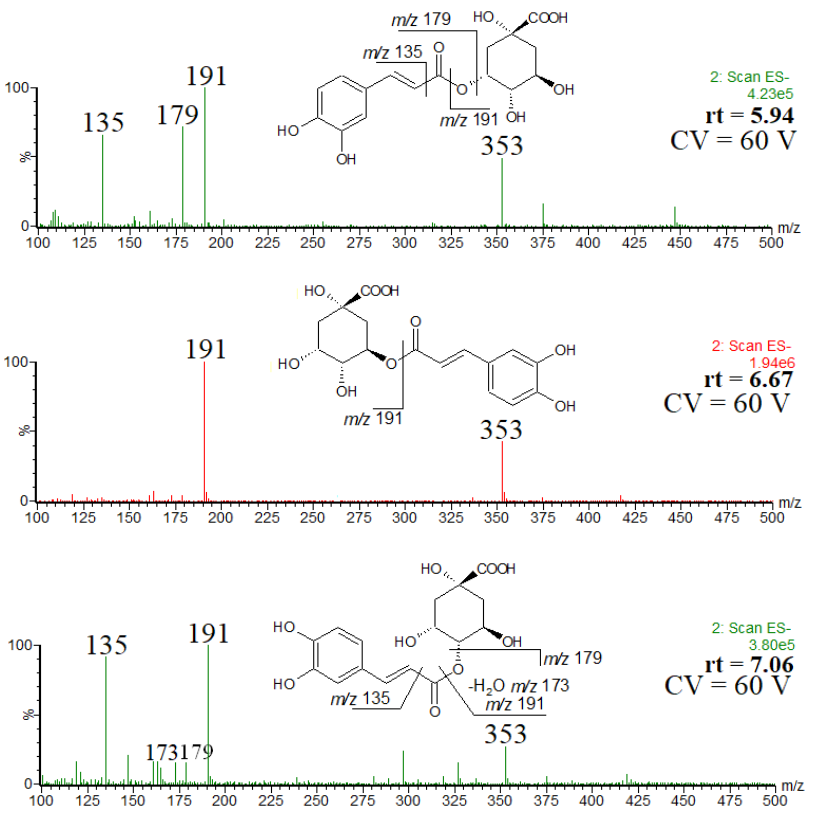
Figure 2. ESI mass spectra of chlorogenic acid and its isomers, and the observed fragmentation patterns.